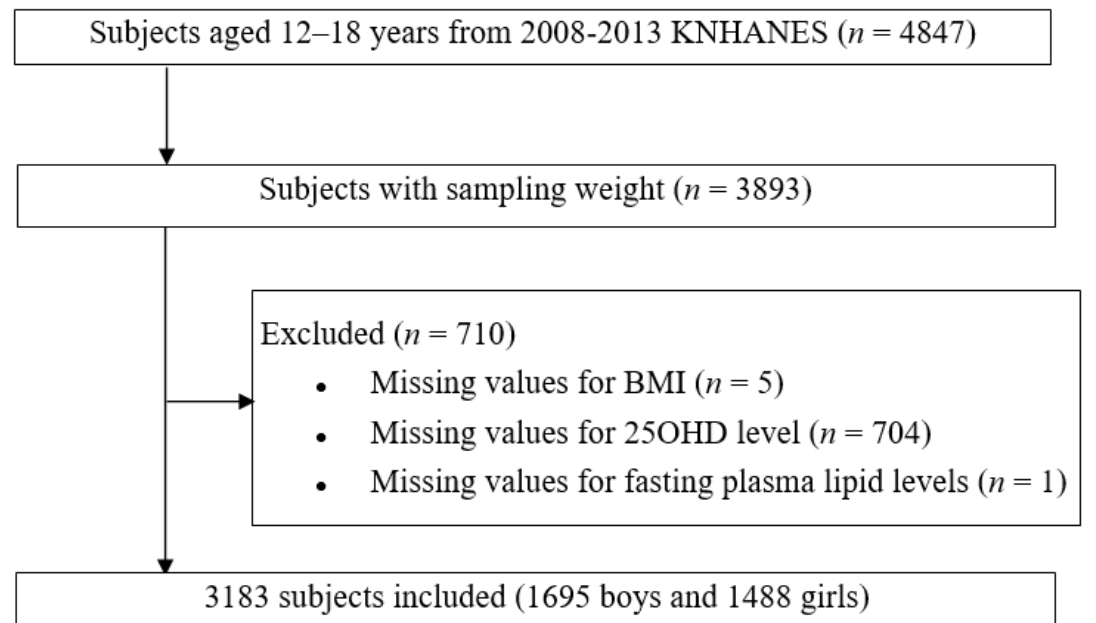
Figure 1. Diagram showing the workflow of the study. KNHANES: Korean National Health and Nutrition Examination Survey; BMI: body mass index; 25OHD: 25-hydroxyvitamin D.